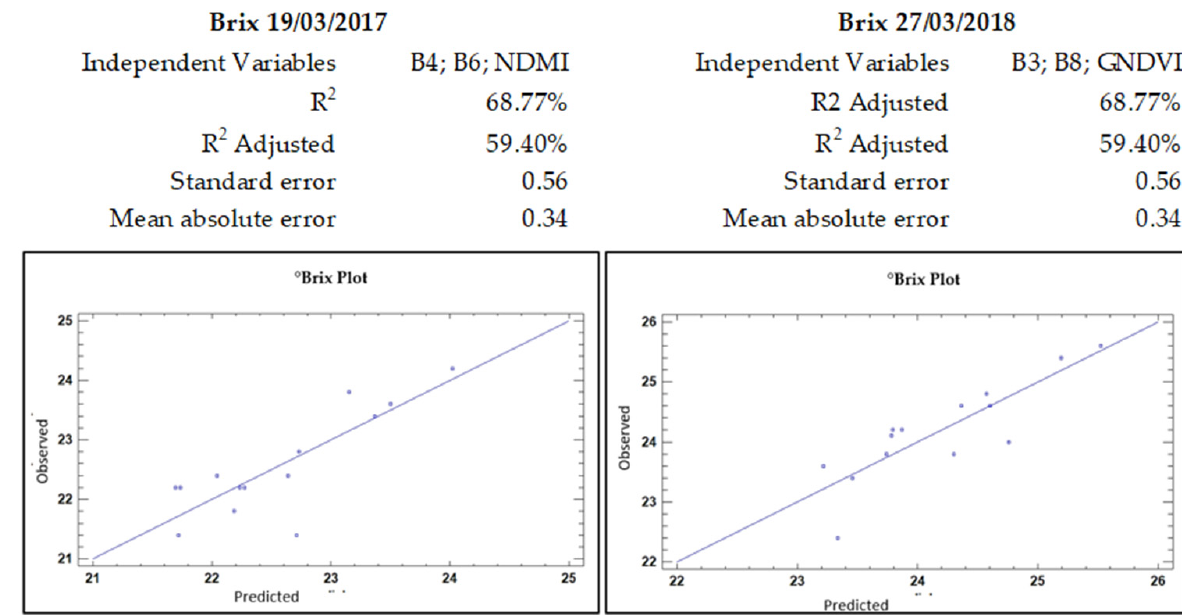
Figure 9. ◦ Brix multiple regression statistics in both seasons. Figure 9. °Brix multiple regression statistics in both seasons. Figure 9. °Brix multiple regression statistics in both seasons.